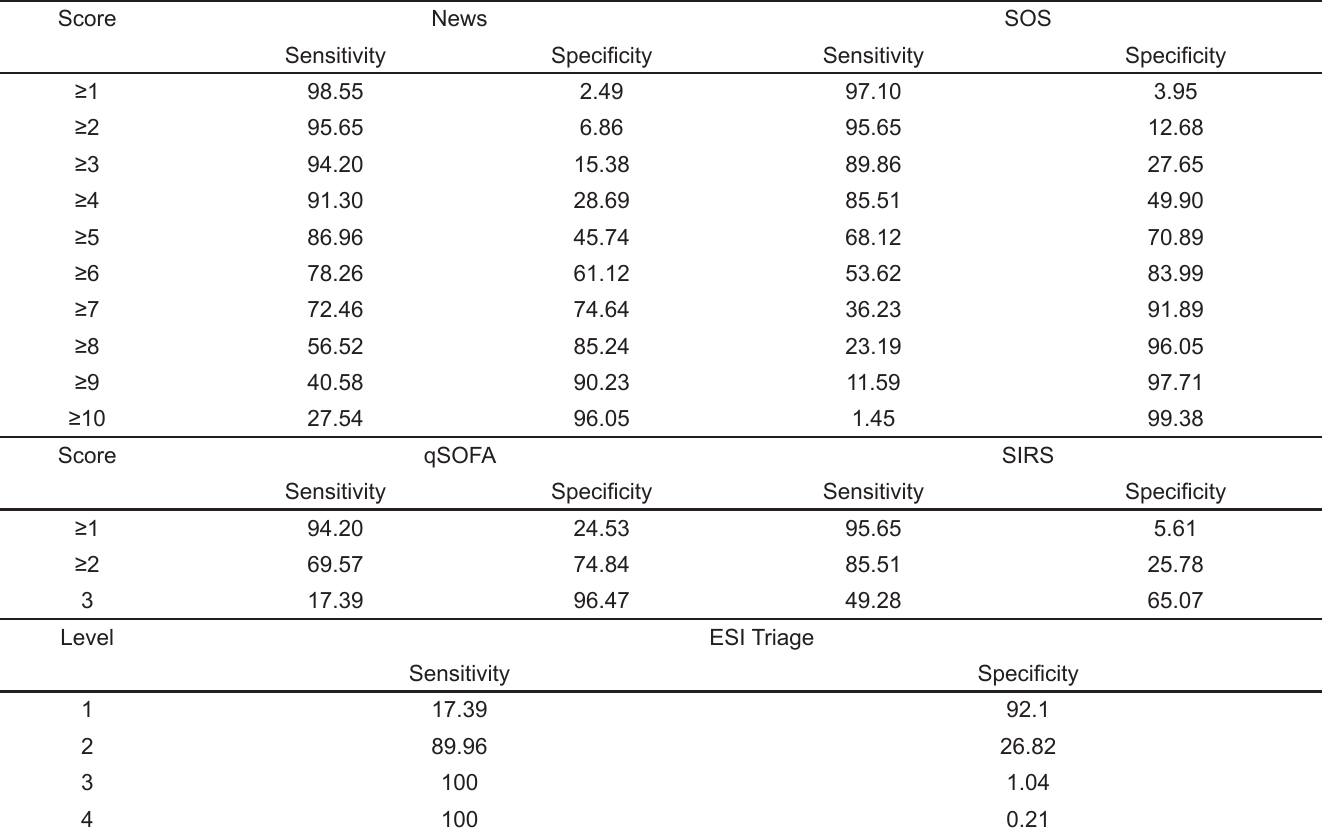
Table 3. Sensitivity and specificity for each predictive score for predicting 28-day